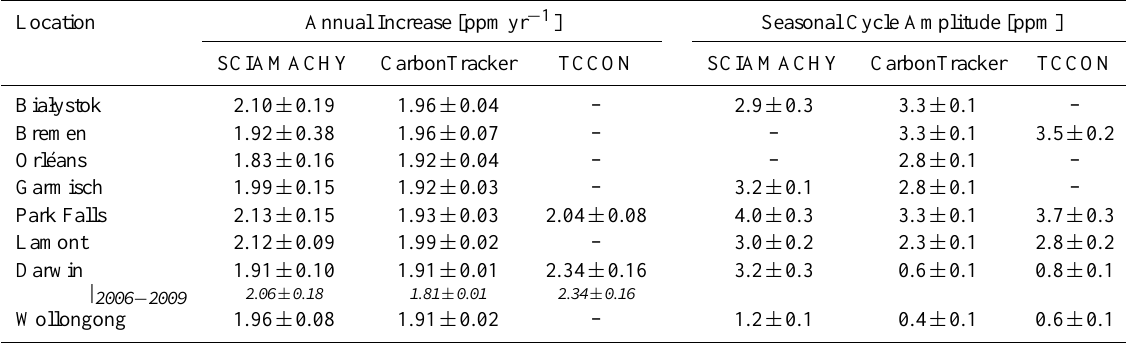
Table 2. Annual increase and seasonal cycle amplitude at the analysed TCCON sites. The increase is calculated from the unsmoothed data and the amplitudes are derived from smoothed time series as in Fig. 2. The numbers in italic for Darwin show the results of the trend analysis when restricting to 2006–2009 to harmonise the time periods of TCCON and